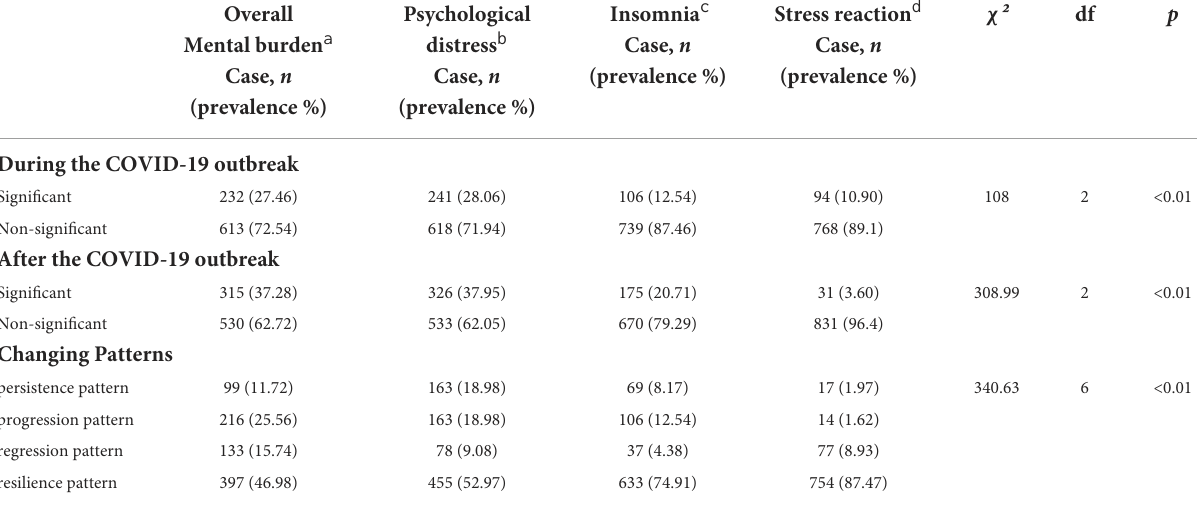
Insomnia c Stress reaction d Case, n Case, n (prevalence %) (prevalence